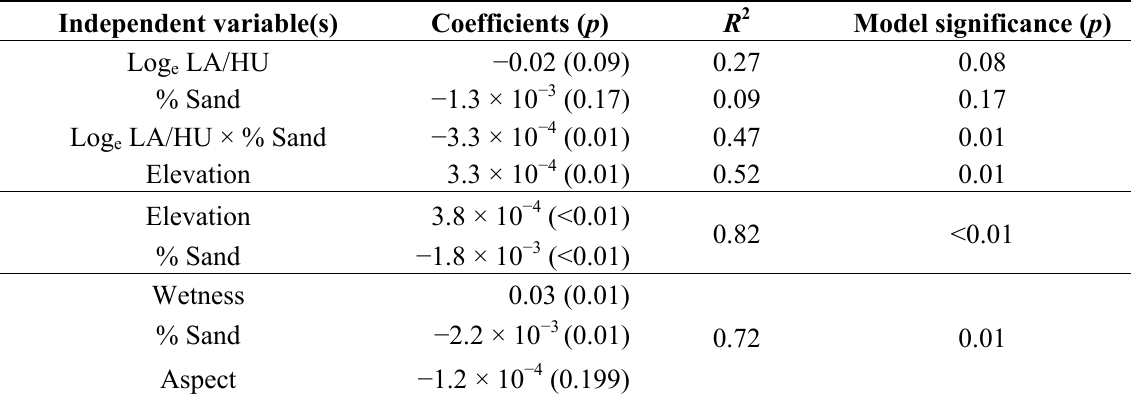
Table 2. Relationship between mean soil %N and housing density; summary linear regressions on mean soil %N.